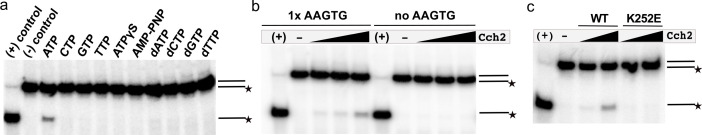
Cch2 helicase activity requires ATP, the AAGTG iteron sequence in the substrate oligo, and catalytic Lys252.(a) Dependence of Cch2 (3µM) helicase activity on various nucleotide cofactors in the presence of a dsDNA substrate with a 3’ overhang (HELA-5F/HELA-6R; Supplementary file 1 - Table 2). (+) control denotes a sample with no protein added that was subjected to 95 °C heat treatment. (-) control denotes no-protein sample. (b) Dependence of Cch2 (1-3µM) helicase activity on the presence of the iteron sequence AAGTG within the dsDNA substrate containing a 3’ overhang. The AAGTG sequence in the right panel was replaced with unrelated sequence, while the surrounding basepairs remained unchanged (see Supplementary file 1 - Table 2). (+) denotes a positive control sample subjected to 95 °C heat treatment. (c) Cch2 helicase activity assay with wild-type (WT) and mutant (K252E) Cch2 (2-3µM each) in the presence of a dsDNA substrate with a 3’ overhang (HELA-5F/HELA-6R; Supplementary file 1 - Table 2). (+) control denotes a sample with no protein added that was subjected to 95 °C heat treatment. (-) control denotes no-protein sample.